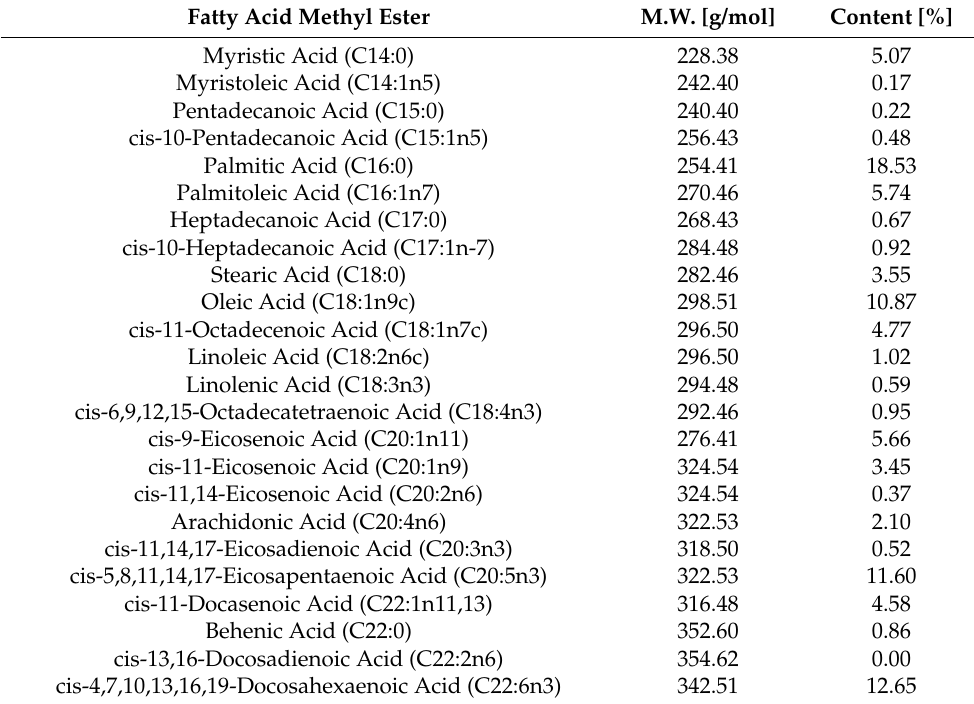
Table 1. The contents of fatty acids derived from squid liver in this